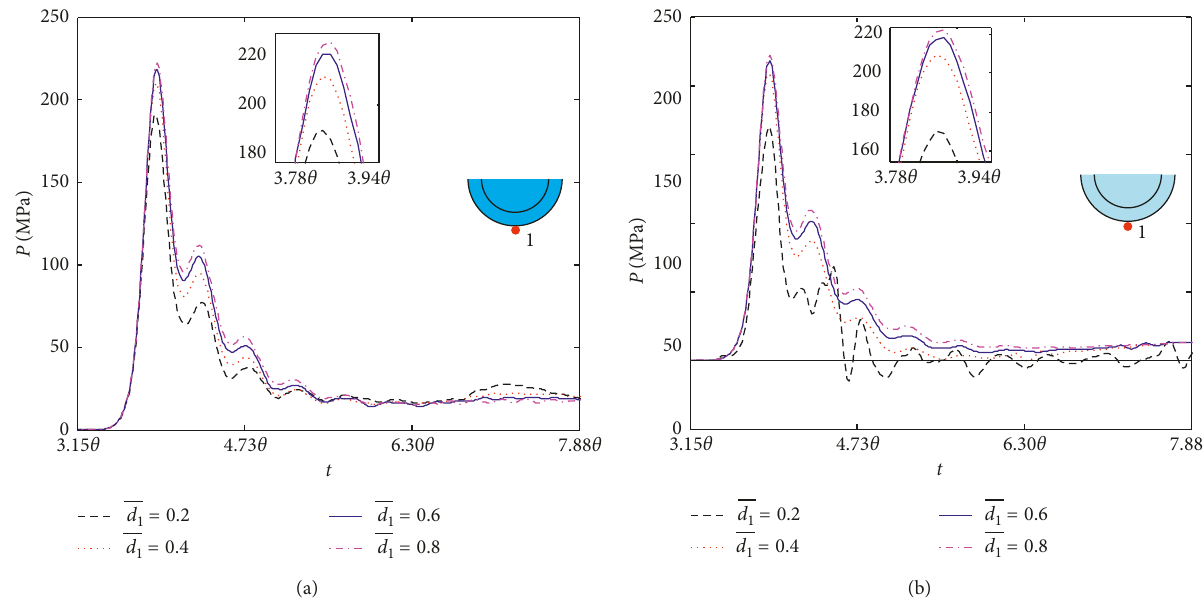
Figure 11: The pressure at gauging point 1 for the cases of different thicknesses of the outer shell (dark color represents water and light color represents air). (a) Media 1 and 2 filled with water. (b) Media 1 and 2 filled with